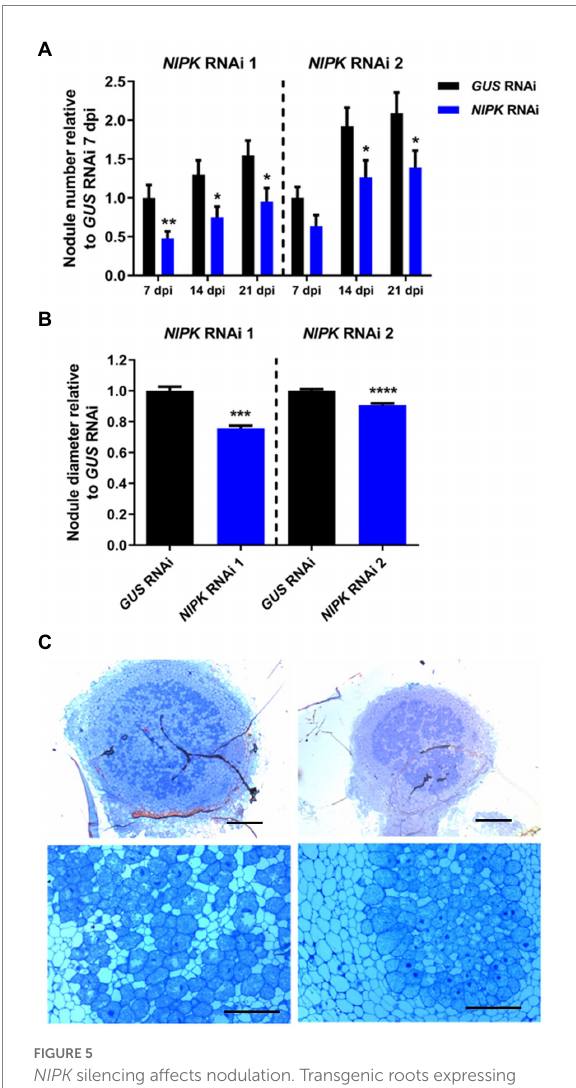
FIGURE 5 NIPK silencing affects nodulation. Transgenic roots expressing NIPK RNAi or GUS RNAi were grown for 7 days without nitrate and inoculated with the SC15 strain of Rhizobium etli . (A) The number of nodules was recorded at 7, 14, and 21 days after infection. The GUS RNAi value at 7 days post-infection (dpi) is used as reference. (B) Nodule diameter was measured at 21 dpi. Error bars in (A,B) represent SEM. Significant differences in a t - test are indicated with asterisks (*, p < 0.05; **, p < 0.01; ***, p < 0.001; ****, p < 0.0001). (C) Nodule structure of GUS RNAi (left panels) or NIPK RNAi 1 (right panels) plants 14 dpi with R. etli stained with toluidine blue. Scale bars: 200 μ m (upper panels), 50 μ m (lower